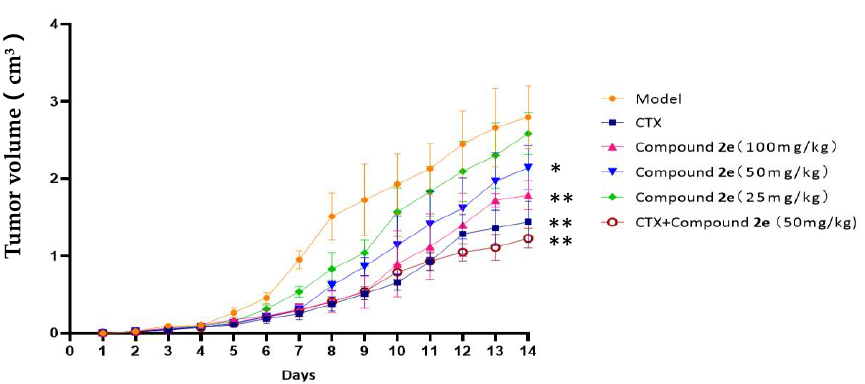
Figure 3. Effect on tumor volume. Compared with the model group, * p < 0.05, ** p < 0.01. Tumors of the model group reached 10 – 18 mm in diameter on day 14. While CTX, compared with model group. It was showed that compound 2e groups (50, 100 mg/kg) ( p < 0.05, p < 0.01). Treatment with compound 2e could decrease the tumor weight